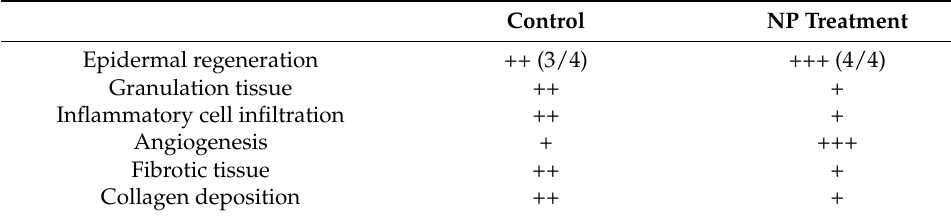
Table 2. The assessment of histological parameters for wound healing. Control NP Treatment Epidermal regeneration ++ (3/4) +++ (4/4) Granulation tissue ++ + Inflammatory cell infiltration ++ + Angiogenesis +++ Fibrotic tissue